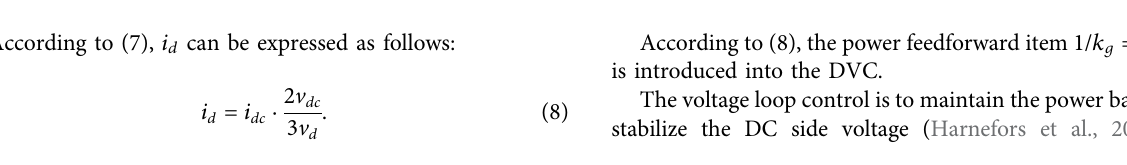
FIGURE 9 | (A) Impedance ratio curves of different k pv ; (B) impedance ratio curves of different k ppll .